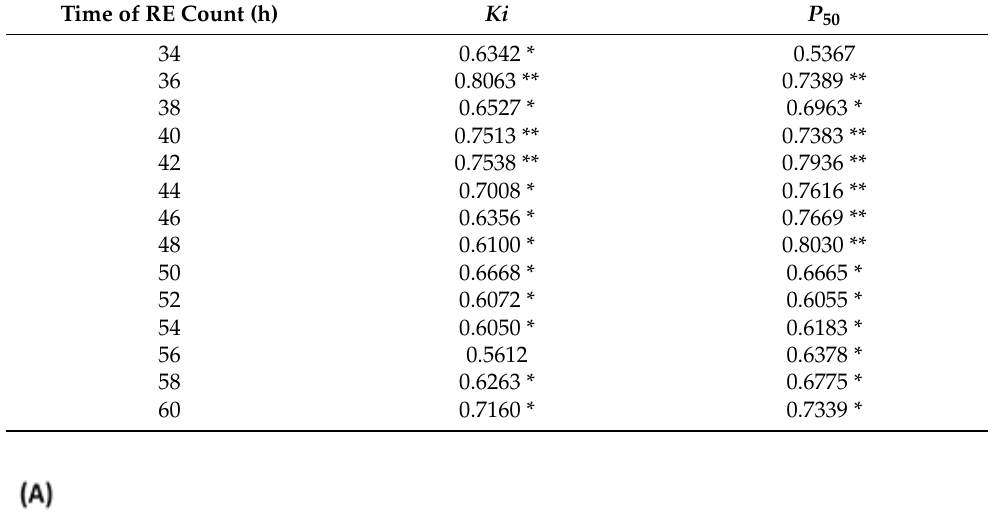
Table 3. Correlation coefficients of RE count between 34 h and 60 h and probit values of Ki and P 50 (days) for seed lots of ten hybrid watermelon cultivars. Significance: * is 0.05, and ** is 0.01.